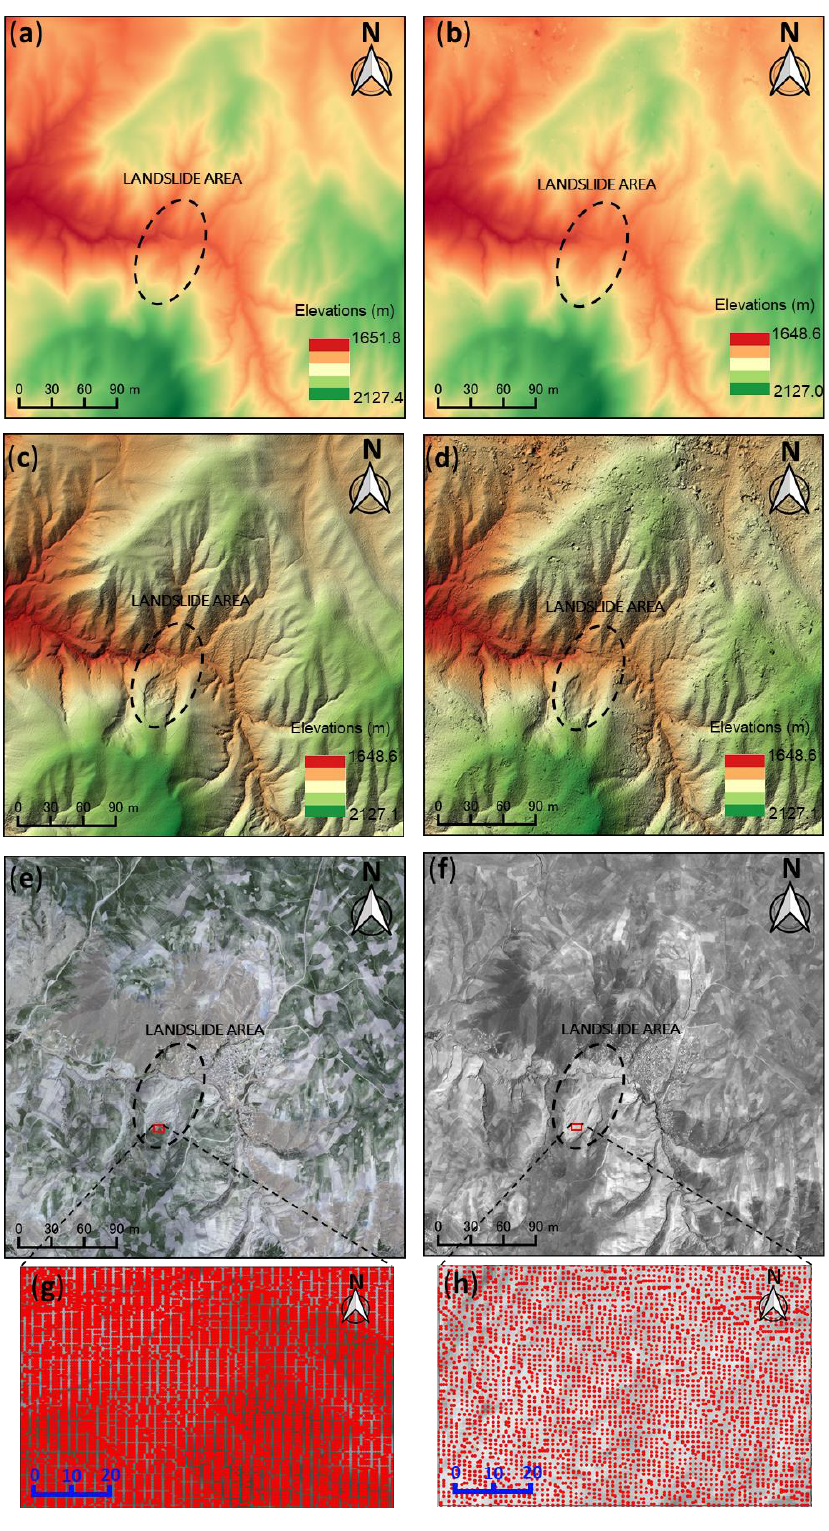
Figure 4. Data used in this study. ( a ) Generated 1 m-resolution pre-event DEM from the GeoEye-1 Satellite in June 2012; ( b , c ) pre-and post-event hillshades effects to the DEMs overlay with colors showing clear details of the study area; ( d ) generated 1 m-resolution post-event DEM from the IKONOS-1 Satellite in July 2014; ( e ) pre-event orthorectified multispectral image derived from GeoEye-1 images (0.5 m-resolution); ( f ) post-event orthorectified panchromatic image derived from IKONOS-1 images (0.8 m-resolution); close-up view of the generated point clouds of pre-event data ( g ) and post-event data ( h ) presents the rectangular area shown in ( e , f ).